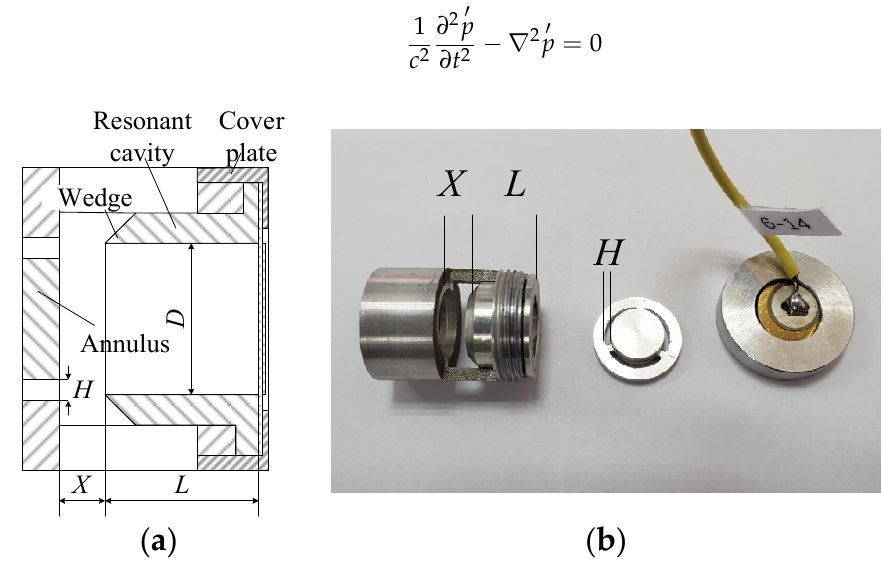
Figure 3. Structural parameters of airflow induced acoustic generator. ( a ) Structure diagram, ( b ) Physical exploded diagram.